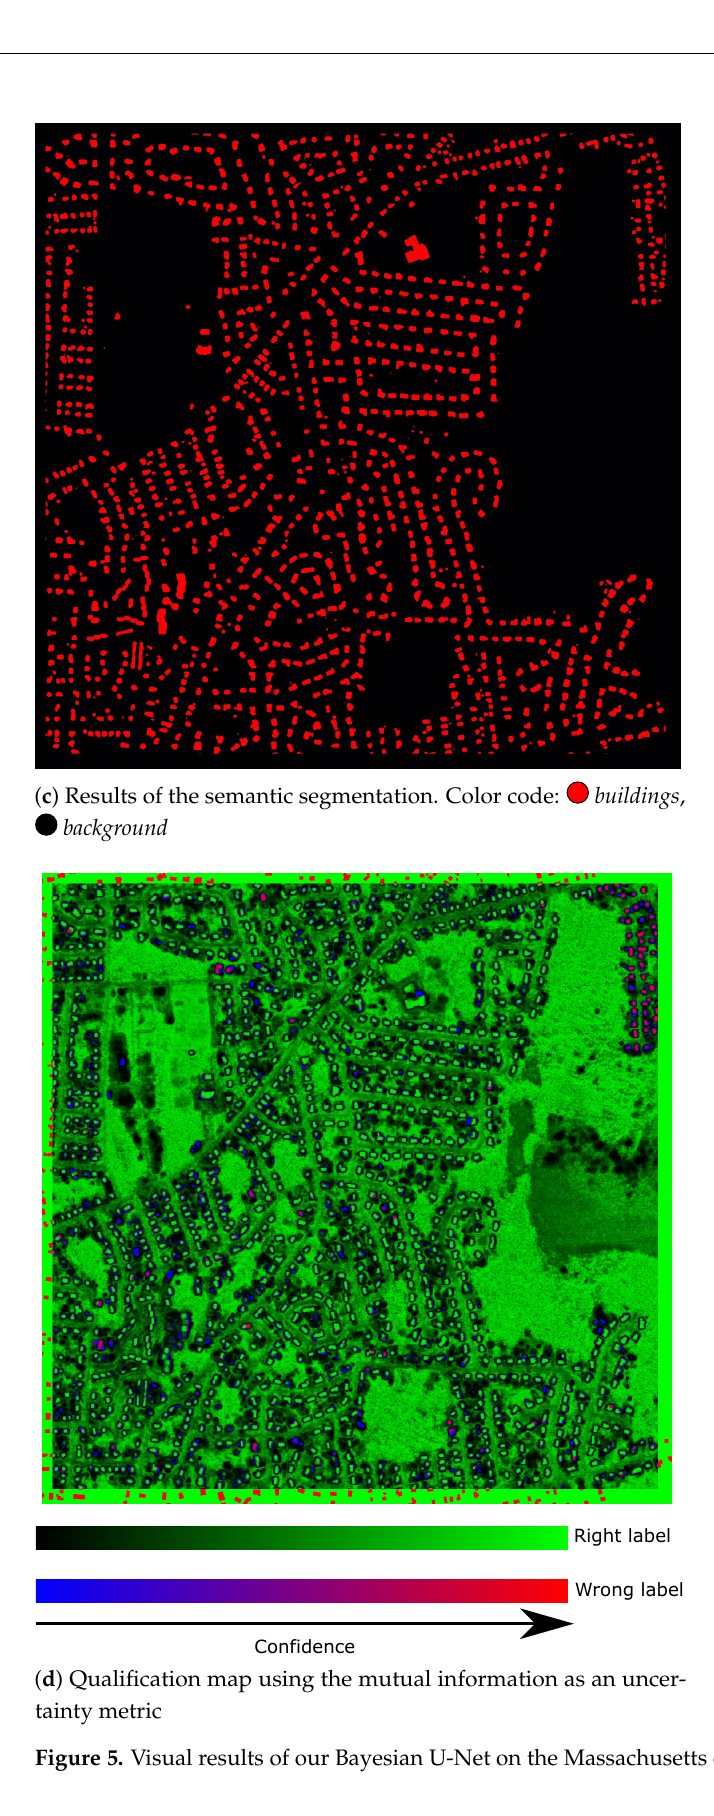
Figure 5. Visual results of our Bayesian U-Net on the Massachusetts